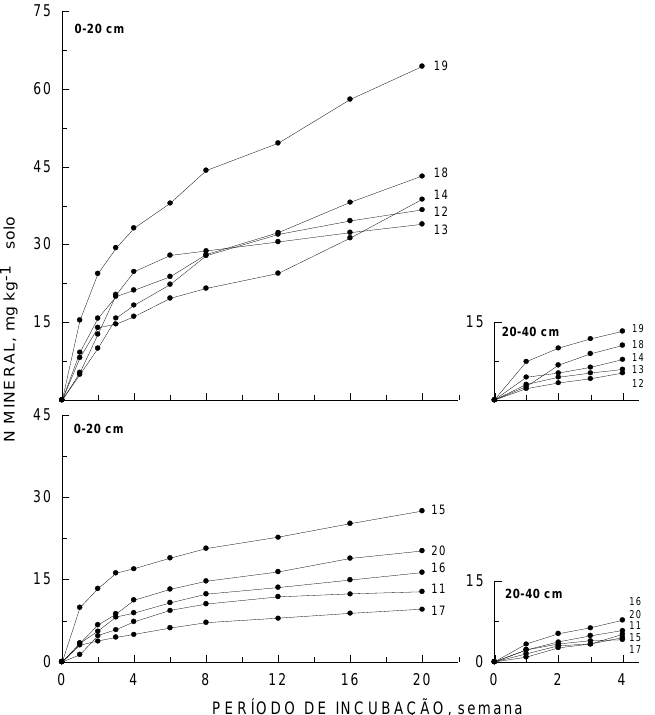
Figura 2. Mineralização acumulada de nitrogênio (NH 4+ + NO 3- ) em amostras das camadas de 0-20 e 20-40 cm de solos da zona semi-árida de Pernambuco, incubadas por 20 e 4 semanas,